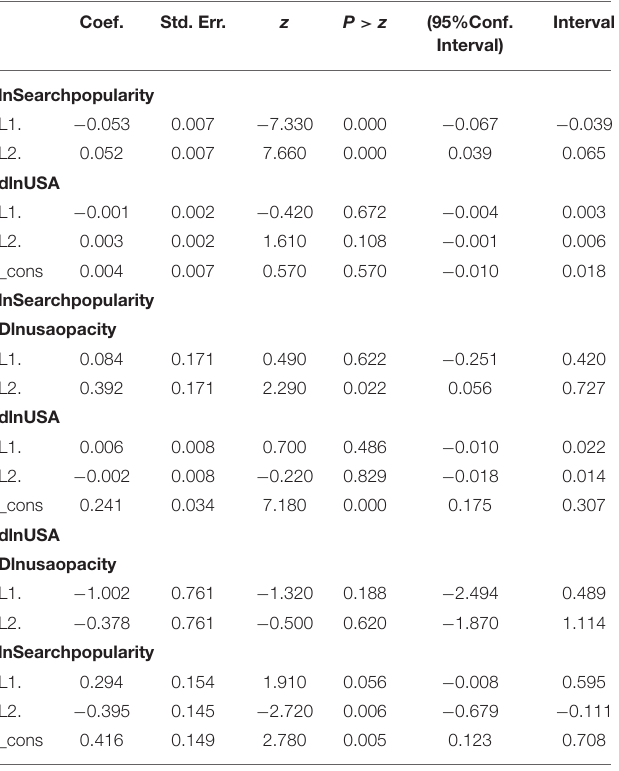
TABLE 6 | VAR estimations for accounting transparency, fear sentiment, and USA daily new patient. Coef.